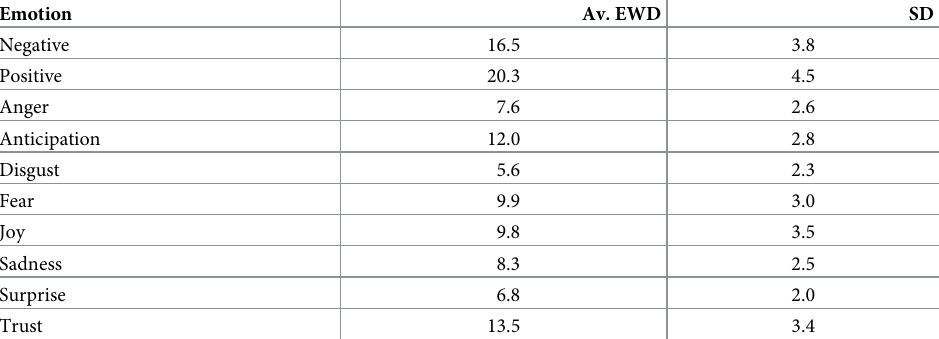
Table 1. Average emotion word density (Av. EWD) and standard deviation (SD) of main characters in IMSDb ( N = 2,687). Emotion